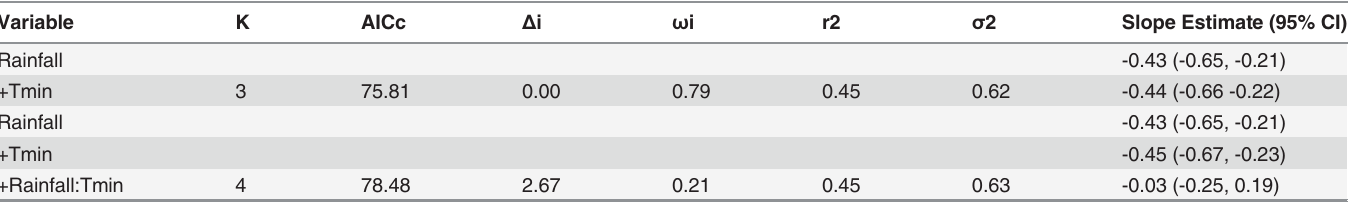
ω 2 = regression i ) = AIC weight, r